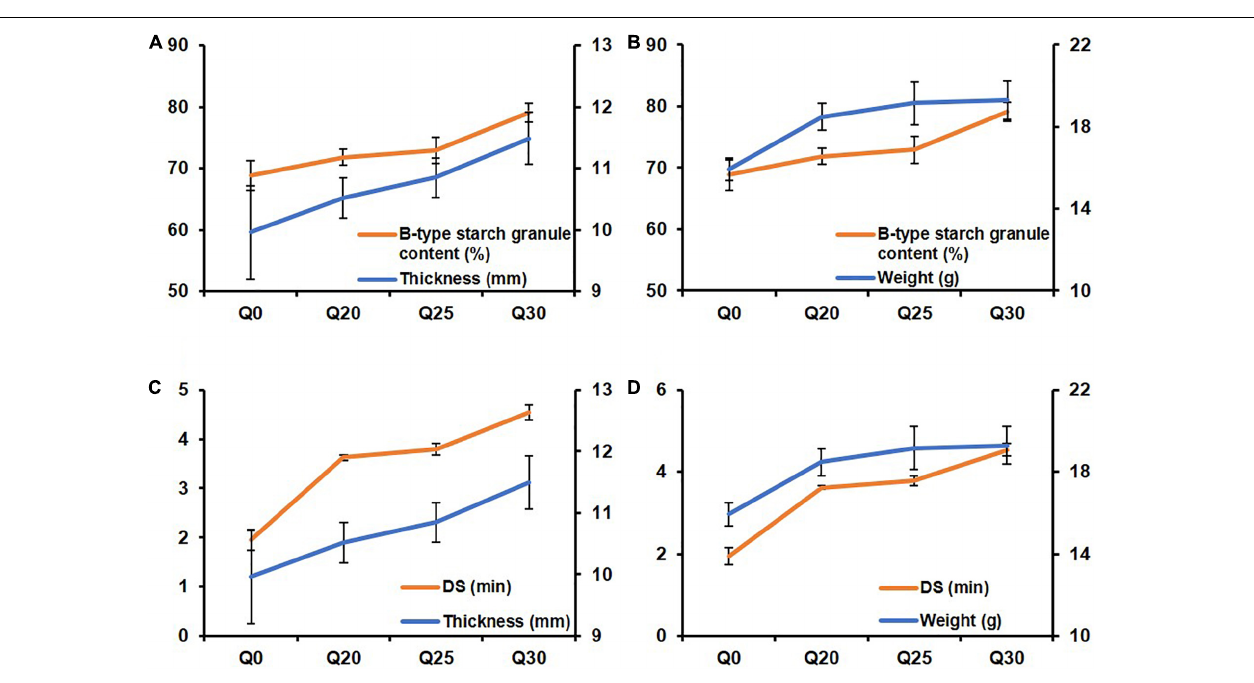
FIGURE 4 | The line charts exhibiting relationship between biscuit properties and starch and rheological properties of quinoa-wheat reconstituted systems. (A) The relationship between B-type starch granule content and crispy biscuit thickness. (B) The relationship between B-type starch granule content and crispy biscuit weight. (C) The relationship between dough stability (DS) and crispy biscuit thickness. (D) The relationship between dough stability (DS) and crispy biscuit